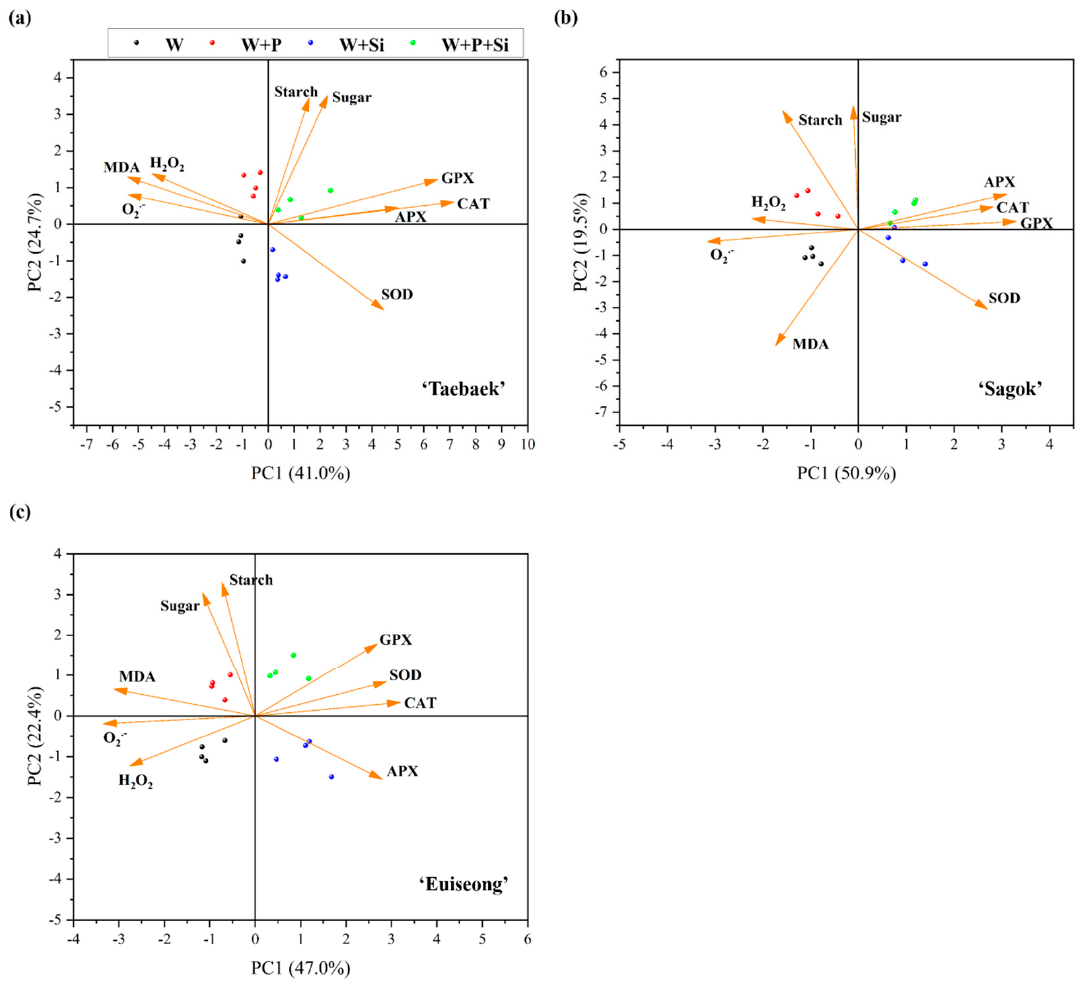
Figure 6. PCA (principal component analysis) on basis of the parameters related to the antioxidant defense system and carbohydrate stock in ( a ) ‘Taebaek’, ( b ) ‘Sagok’, and ( c ) ‘Euiseong’ subjected to the four treatments. SOD: superoxide dismutase, CAT: catalase, APX: ascorbate peroxidase, GPX: guaiacol peroxidase, O 2. − : superoxide radical, H 2 O 2 : hydrogen peroxide, MDA: